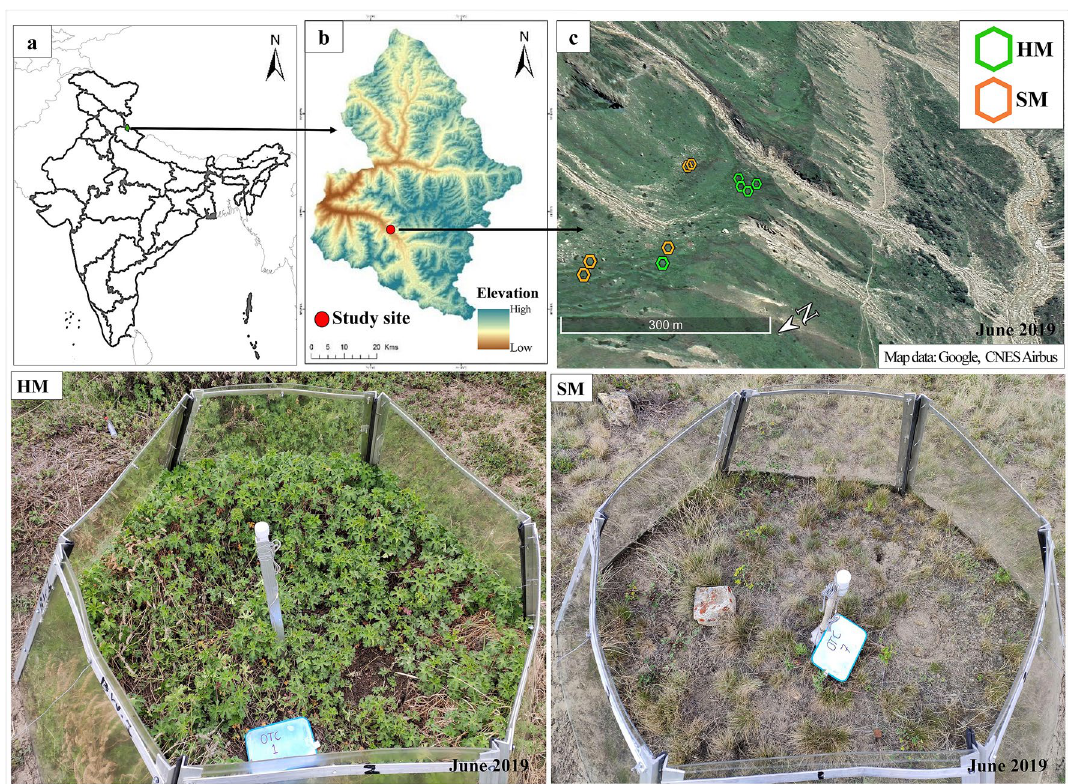
Figure 4. ( a ) State map of India, ( b ) Gangotri National Park and ( c ) Study site with open-top chambers at Herbaceous Meadow (HM) and Sedge Meadow (SM). Maps in figures a and b were generated with ArcGIS version 10.7 (ESRI, CA, USA, https ://deskt op.arcgi s.com/en/arcma p/) and image in figure c was acquired using Google Earth Pro version